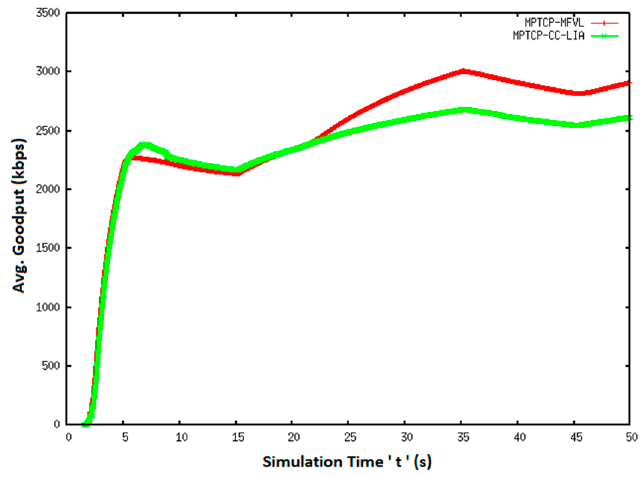
Figure 13. Average goodput result of Setup 3.